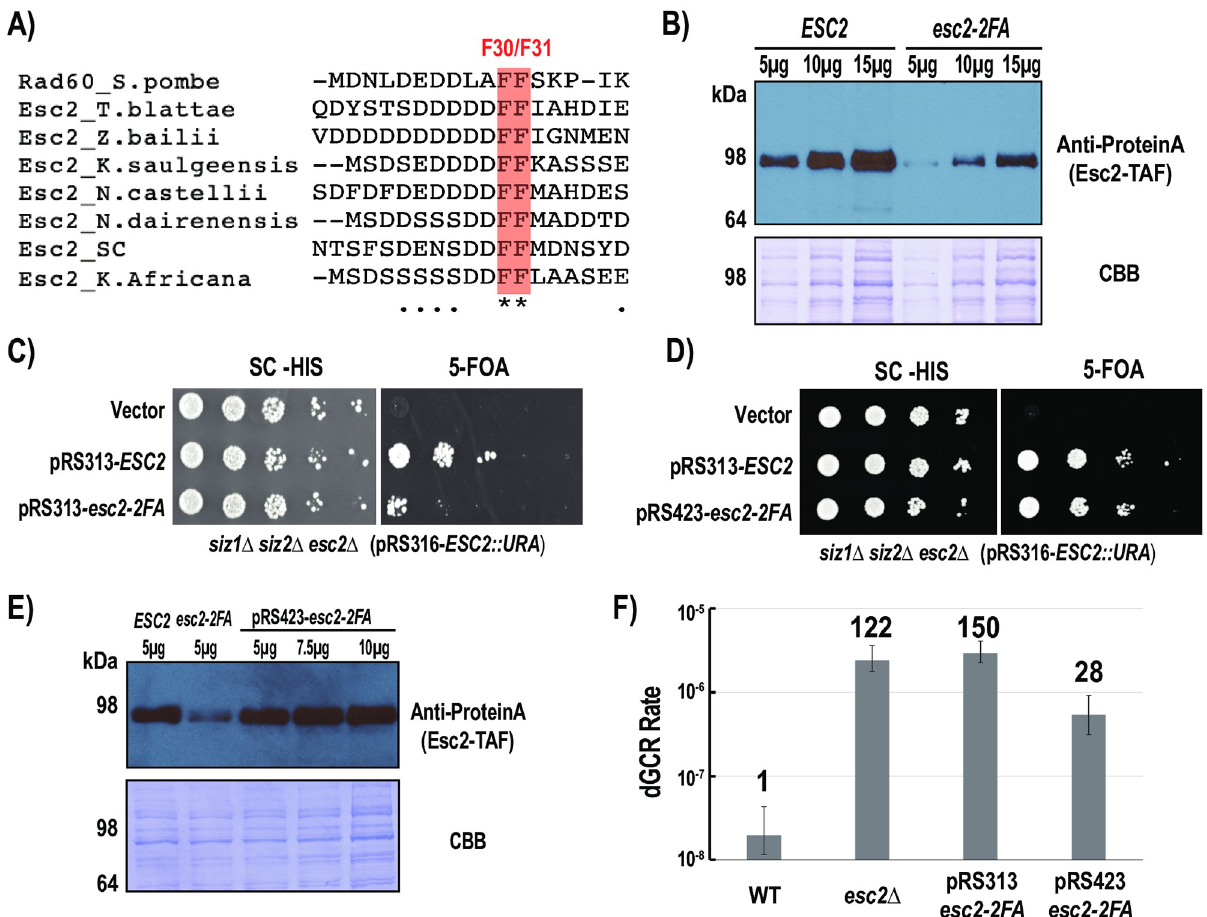
Fig 2. A conserved di-Phe motif in the N-terminus of Esc2 is required for its stability and function. A) Sequence alignment of fungal Esc2 ortholog highlighting the di-Phe motif across eight different fungi. B) 5-FOA plasmid shuffling of a URA3 plasmid expressing ESC2 demonstrates the growth defect of Esc2-2FA when expressed from a centromeric plasmid (low-copy) in the siz1 Δ siz2 Δ esc2 Δ strain background. C) Western blot demonstrating the expression level of the esc2-2FA mutant protein when expressed from a centromeric plasmid. D) 5-FOA plasmid shuffling demonstrates the effect of expressing Esc2-2FA from a high-copy 2-micron plasmid in the siz1 Δ siz2 Δ esc2 Δ mutant background. E) Comparison of protein expression levels of endogenous WT, Esc2-2FA expressed from a centromeric plasmid and Esc2-2FA expressed from a high-copy plasmid. F) dGCR analysis of the esc2- 2FA mutant and the effect of high-copy expression of Esc2-2FA in the esc2 Δ mutant. Error bars represent the upper and lower bounds of the 95% confidence interval with fold changes relative to WT shown above each respective